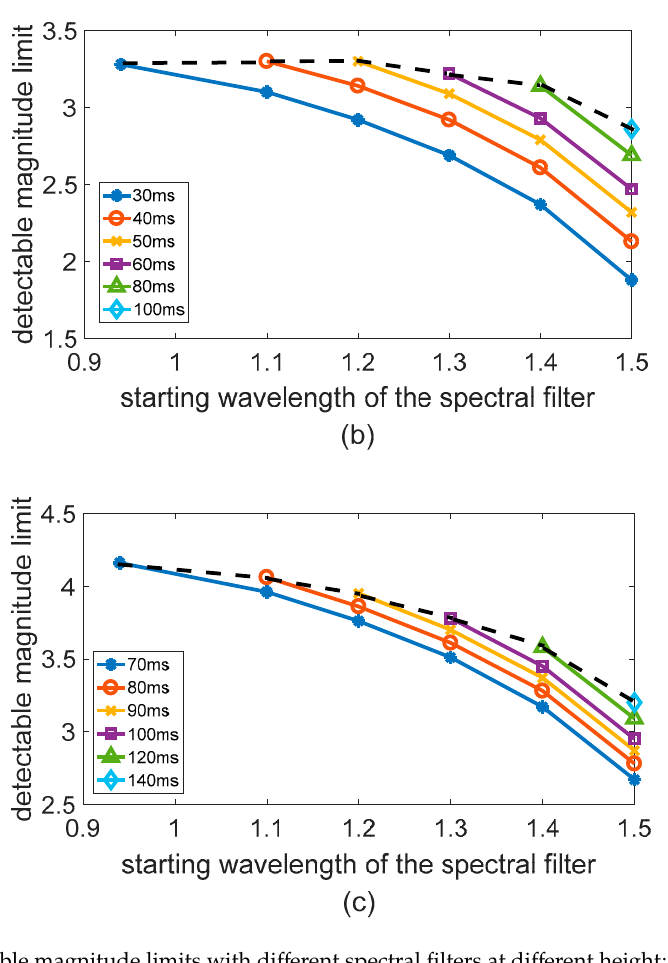
Figure 6. Detectable magnitude limits with different spectral filters at different height; ( a ) 20 km; ( b ) 30 km; ( c ) 40 km. Sensors 2019 , 19 , x FOR PEER REVIEW